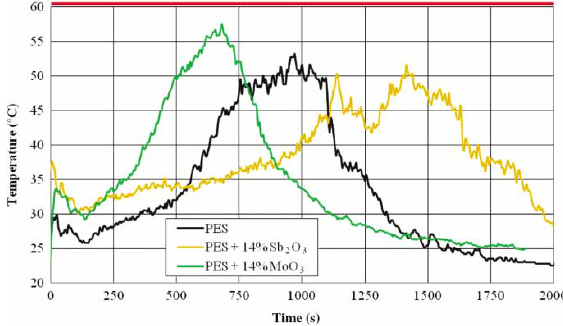
Fig. 8. Temperature curves registered by the thermocouple placed on tree 18 at a height of 2.7 m for three studied